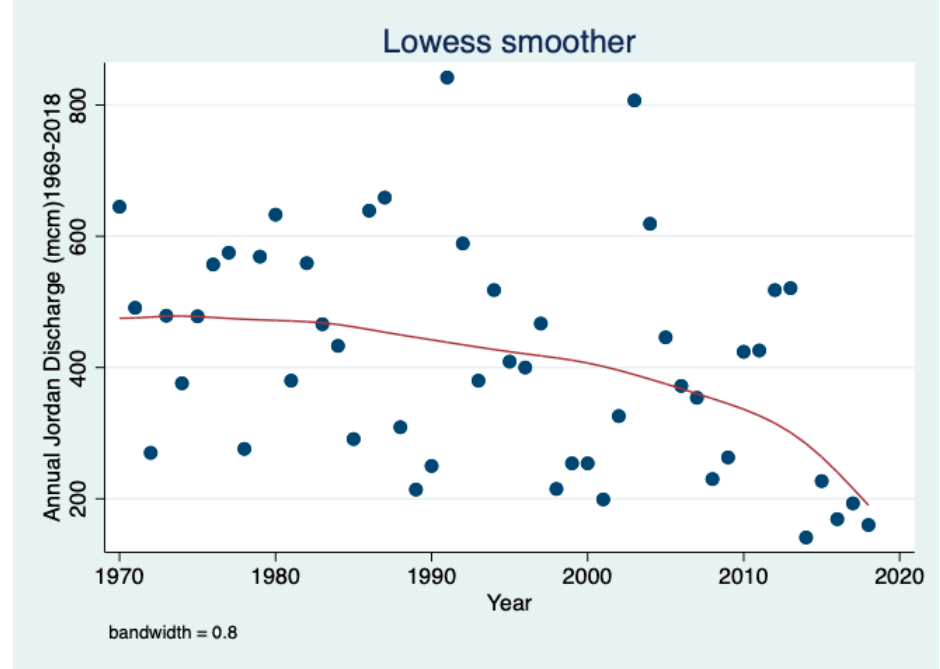
Figure 1. Lowess smoother trend of changes of annual (1970–2018) Jordan River discharge.